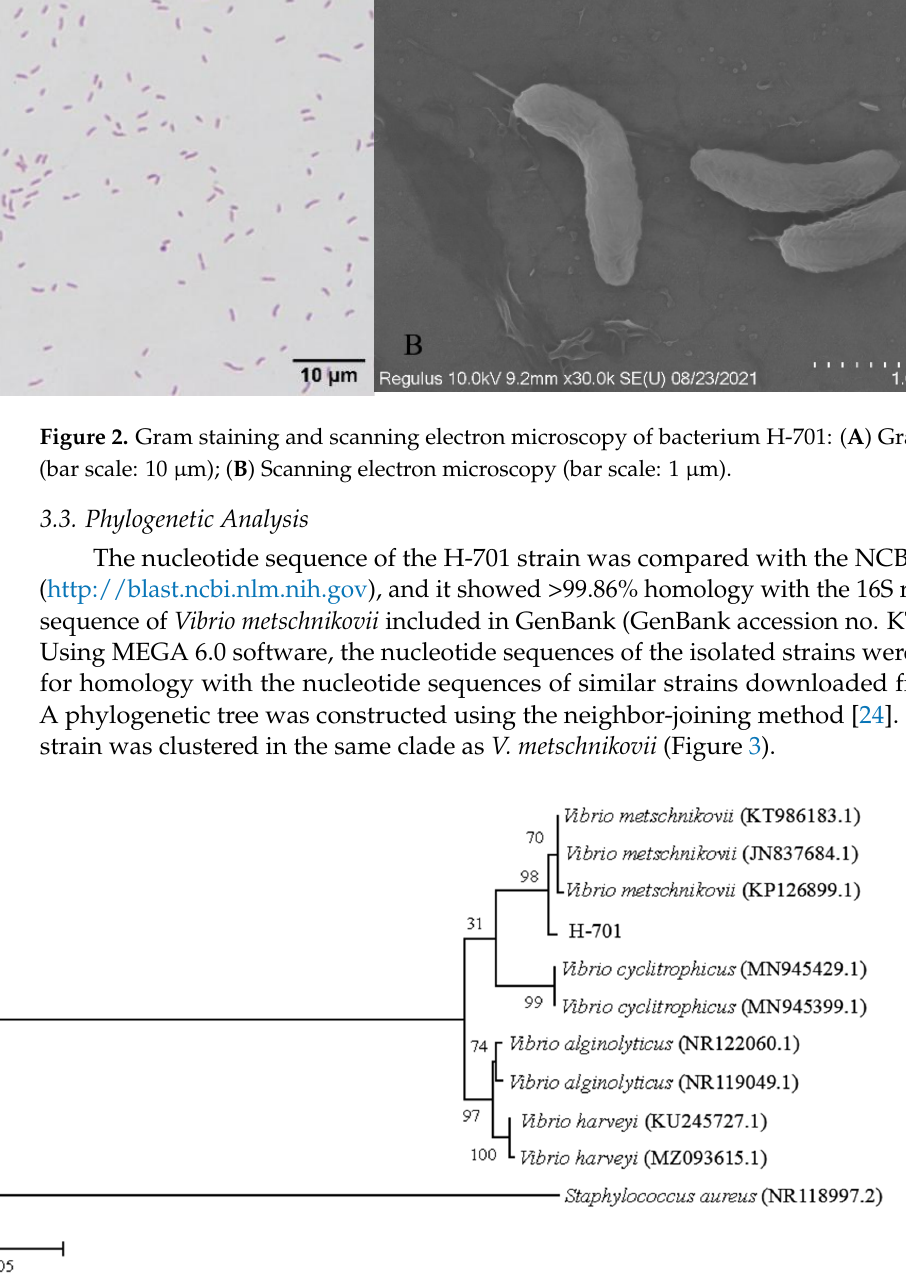
Figure 1. Clinical symptoms of an H-701-infected hybrid sturgeon: ( A ) Body surface (triangle), clo- acal orifice (arrow), and fin (asterisk); ( B ) Ascites (triangle), liver whitening (dot), intestinal wall bleeding (asterisk), and spleen redness (arrow).